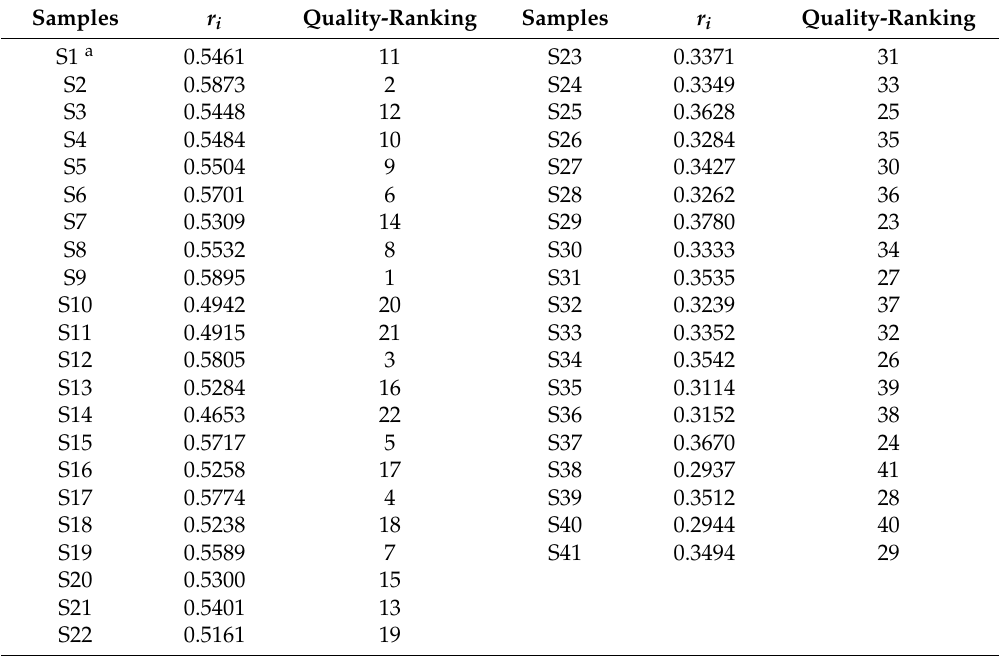
Table 4. Quality sequencing of the 41 tested